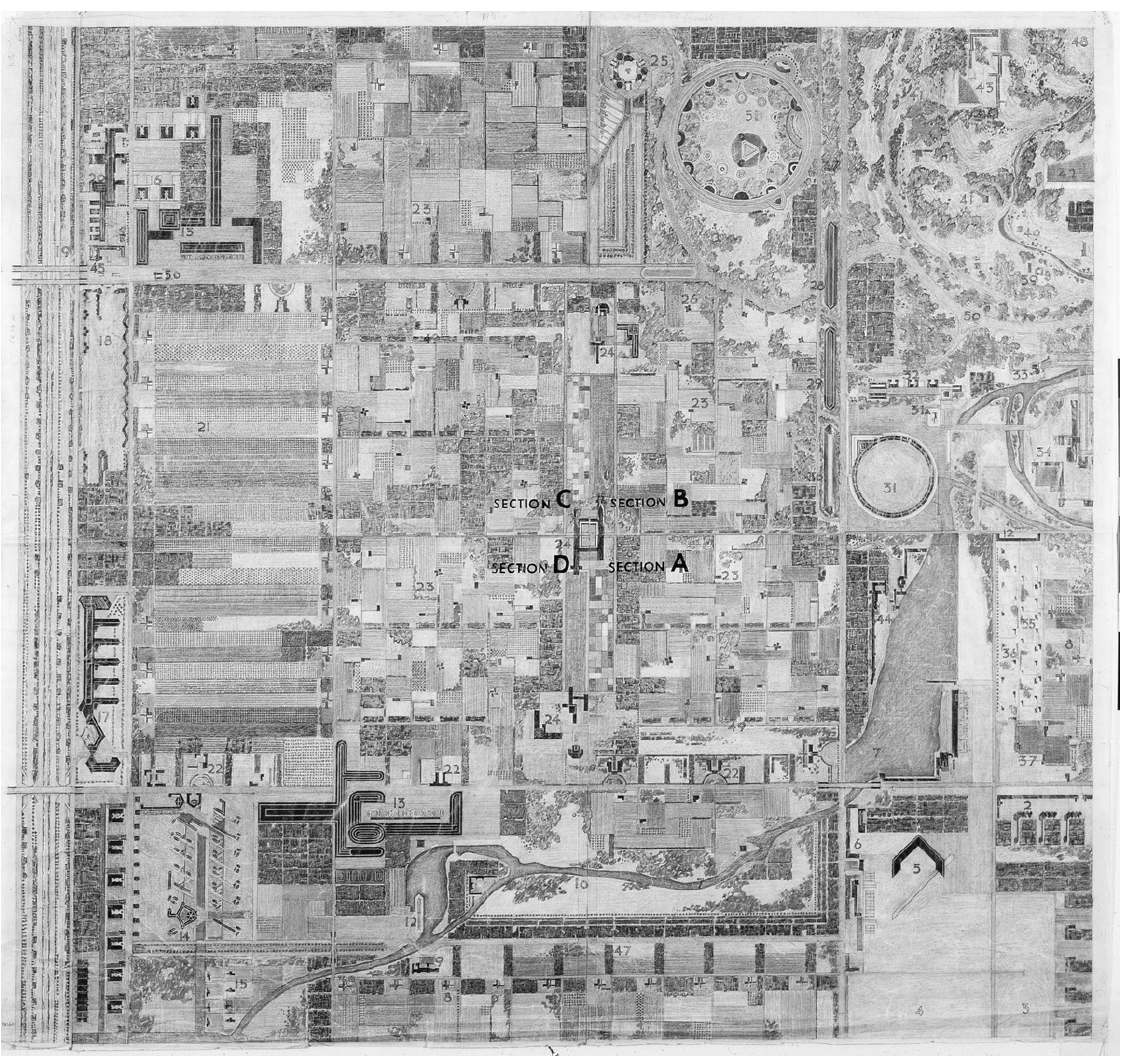
Figure 1. A plan view of the “Broadacre City”, illustrating the mixed use of the